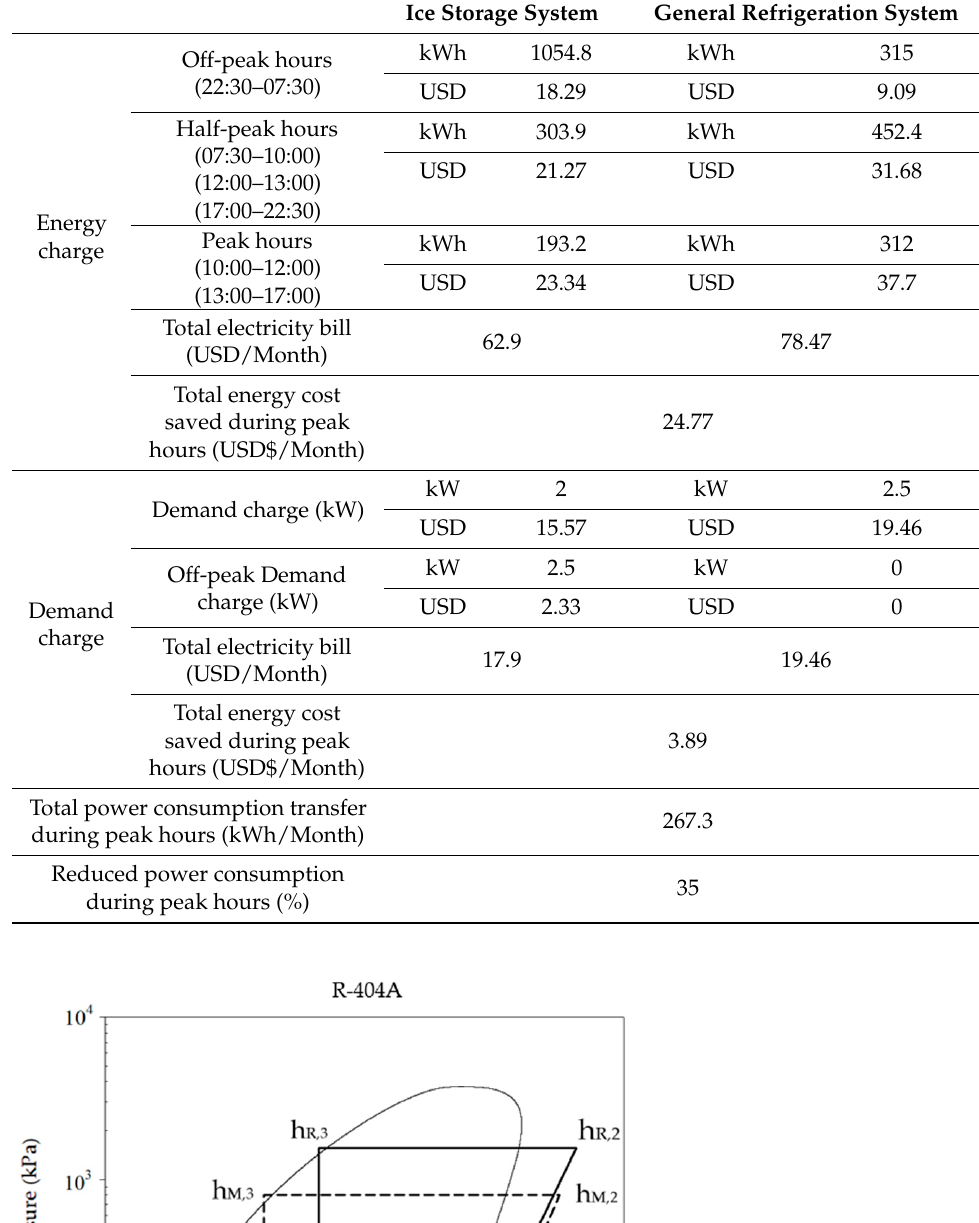
Table 1. Benefit analysis of the two systems (plan 1 and plan 2).